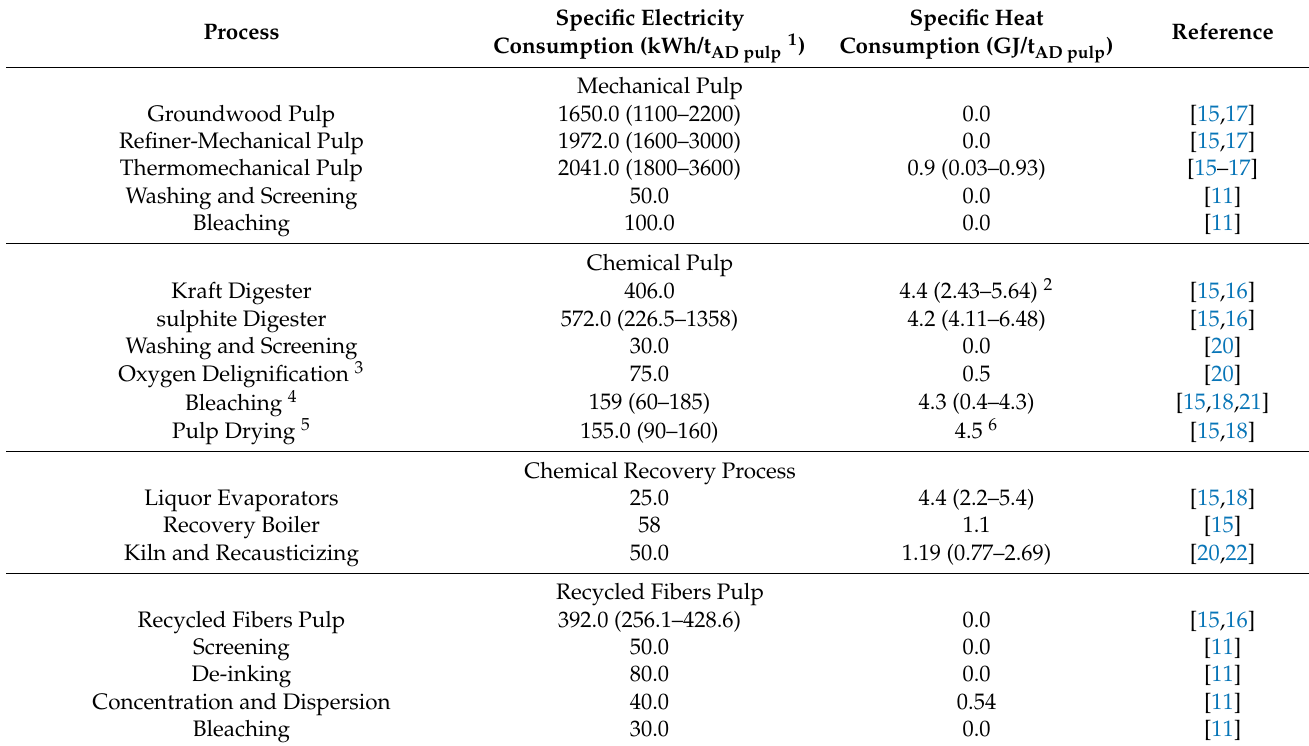
Table 2. Specific electricity and heat consumption of the pulp processes in pulp and paper